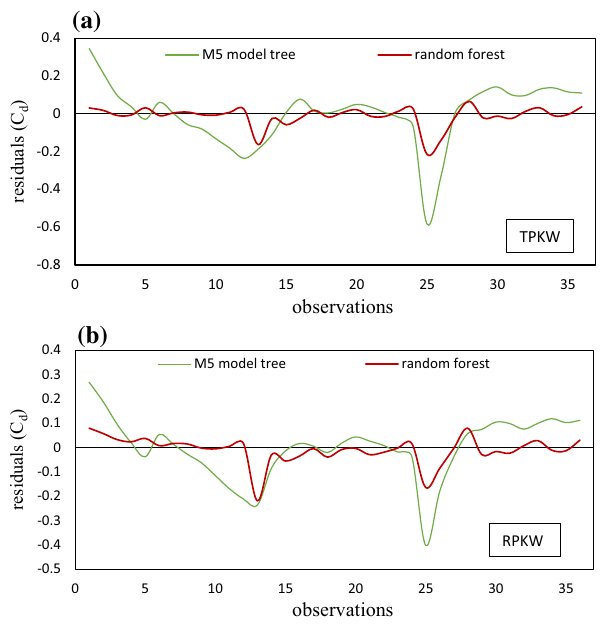
Fig. 11 Comparison of residuals from experimental and predicted values of Cd using M5 tree and random forest method for a trapezoi- dal, and b rectangular PK